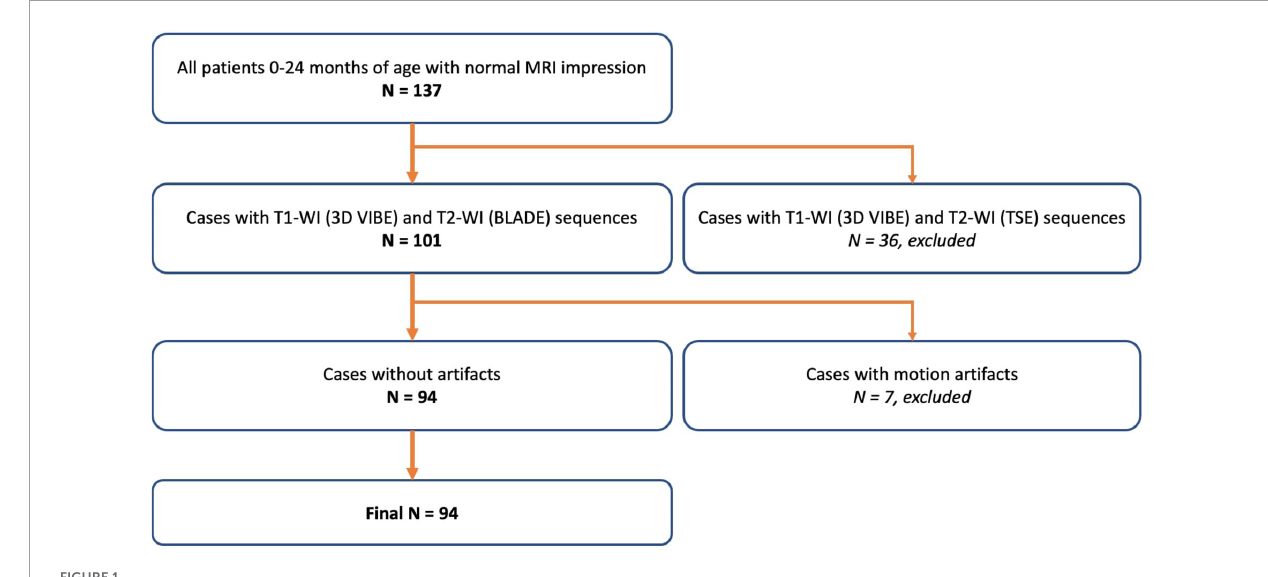
FIGURE1 An overview of the patient selection process.